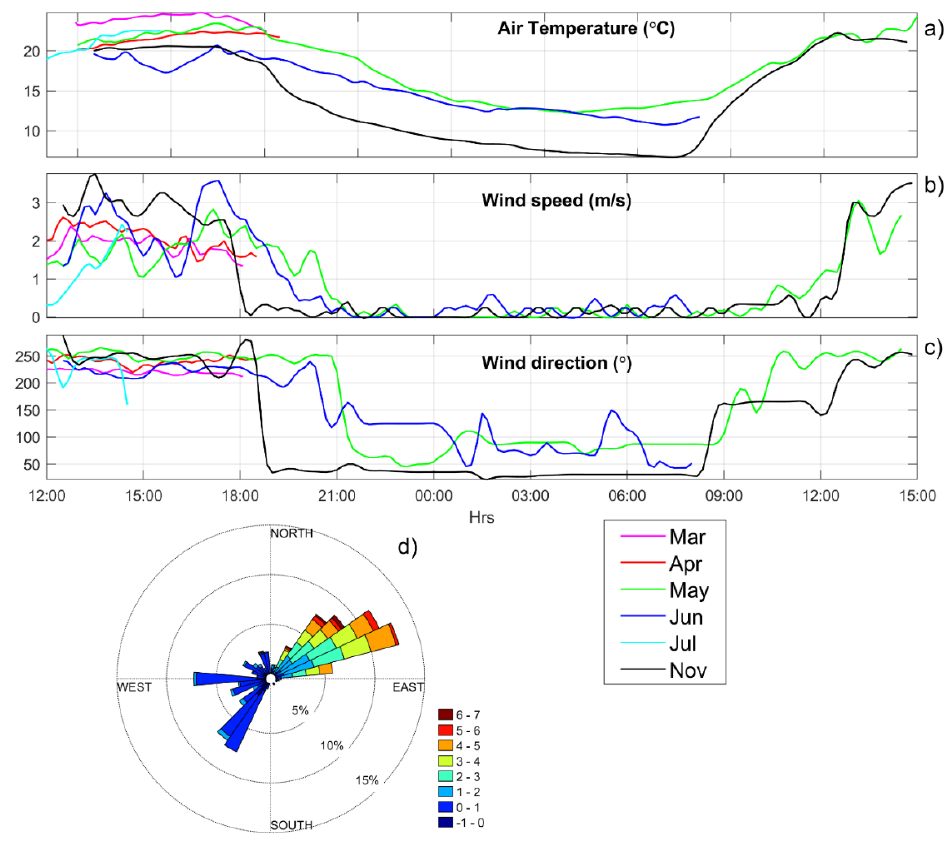
Figure 3. Weather station. Meteorological data of ( a ) air temperature, ( b ) wind speed, and ( c ) wind direction for every field campaign conducted during one or two days in March, April, May, June, July, and November (color legend). In ( d ), the wind rose of the data from the two weather stations located at the rim, with the meteorological convention.